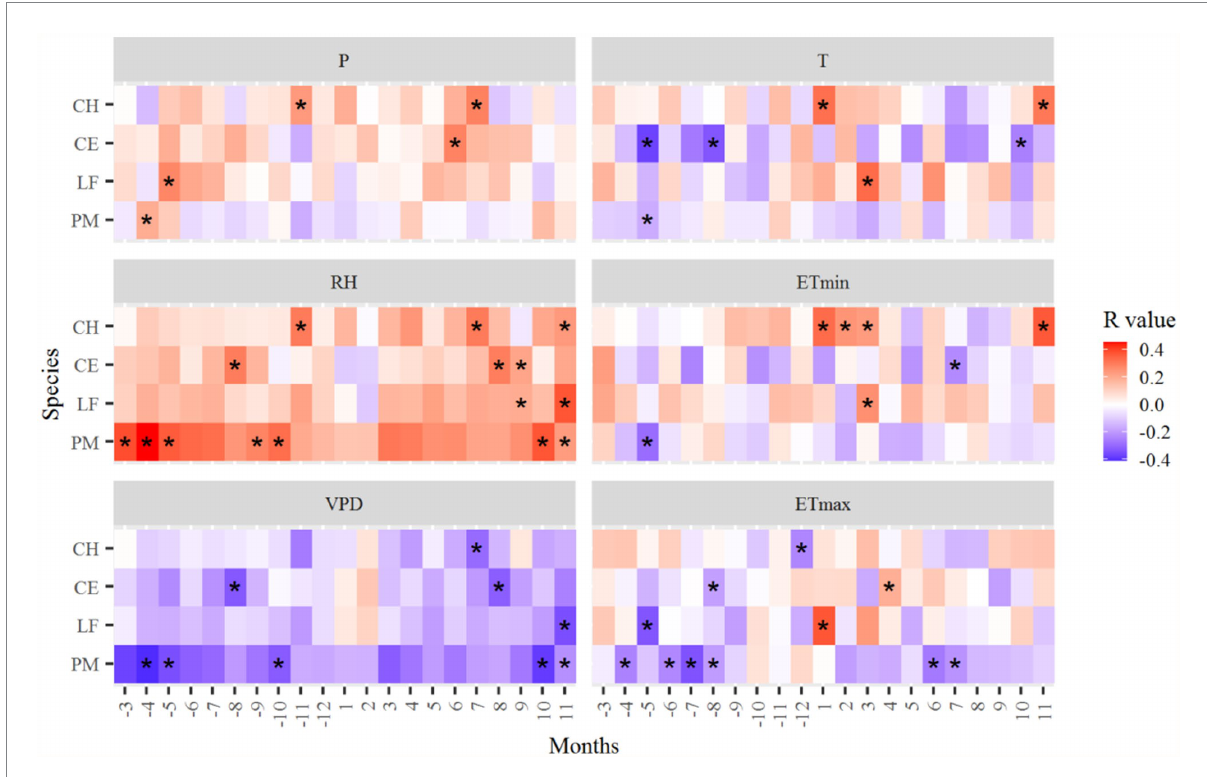
FIGURE 6 Correlation coefficients of the standard tree-ring chronologies in the northern Luoxiao Mountain with monthly main climate factors. P, precipitation, RH, relative humidity, VPD, vapor pressure deficit, T, mean temperature, ETmin, extreme minimum temperature, ETmax, extreme maximum temperature. Correlation analysis was computed for a 21 months window from previous year March to current year November. * p <